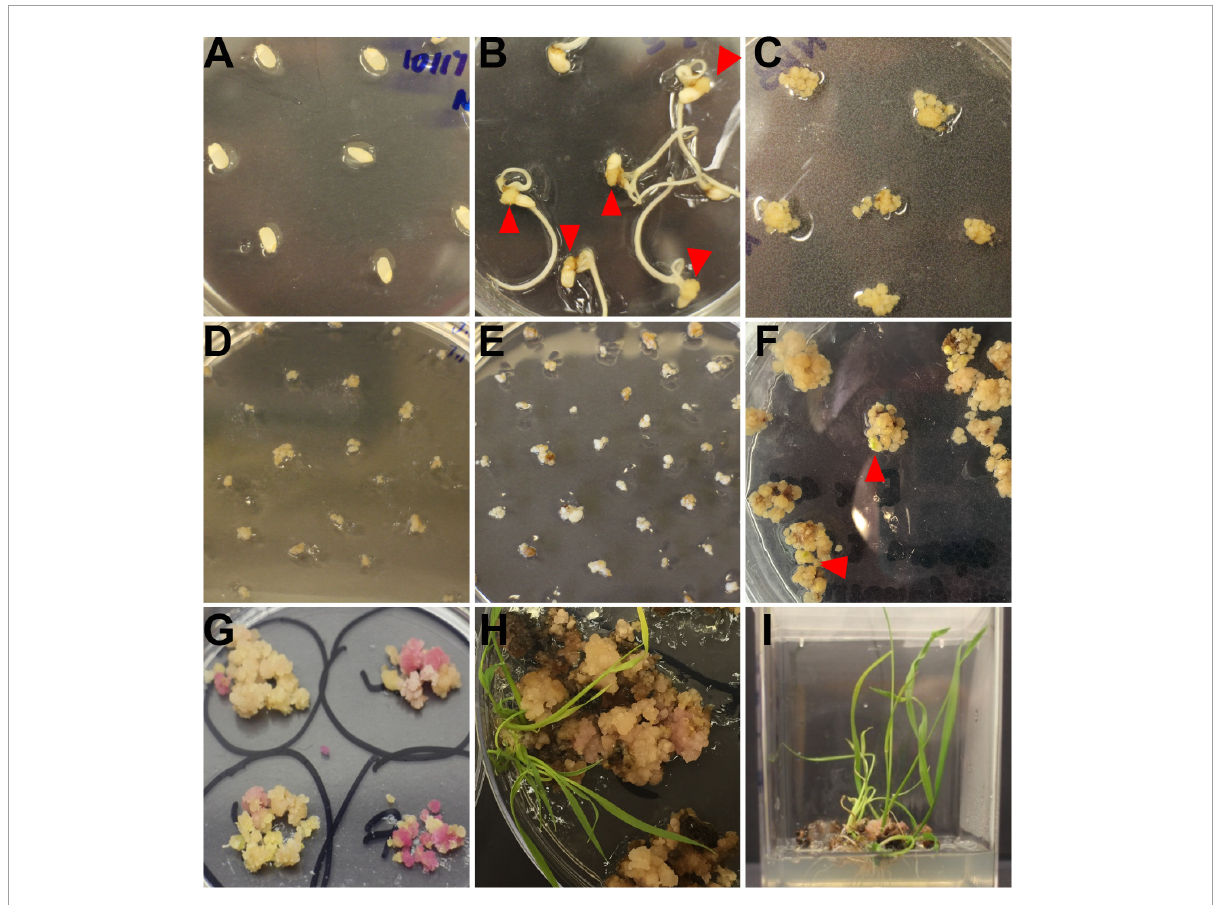
FIGURE2 Workflow of rice transformation. (A) Seeds of Nipponbare on callus induction media. (B) Induced rice calli (red triangle) on callus induction media. (C) Rice calli used for transformation on fresh callus induction media. (D) Transformed calli co-cultured with Agrobacteria, calli were covered by Agrobacteria . (E) Rice calli on hygromycin selection media. Non-transformed calli turned dark brown and died while transformed calli grew fresh white colored calli. (F) Rice calli on shoot regeneration media. Some calli were ready to regenerate rice shoots (red triangle). (G) Rice calli on shoot regeneration media. Positively transformed calli turned red and were ready to generate shoots. (H) Regenerated rice shoots from transformed calli on shoot reaeration media. (I) Rice calli with regenerated shoots and roots on root regeneration media.